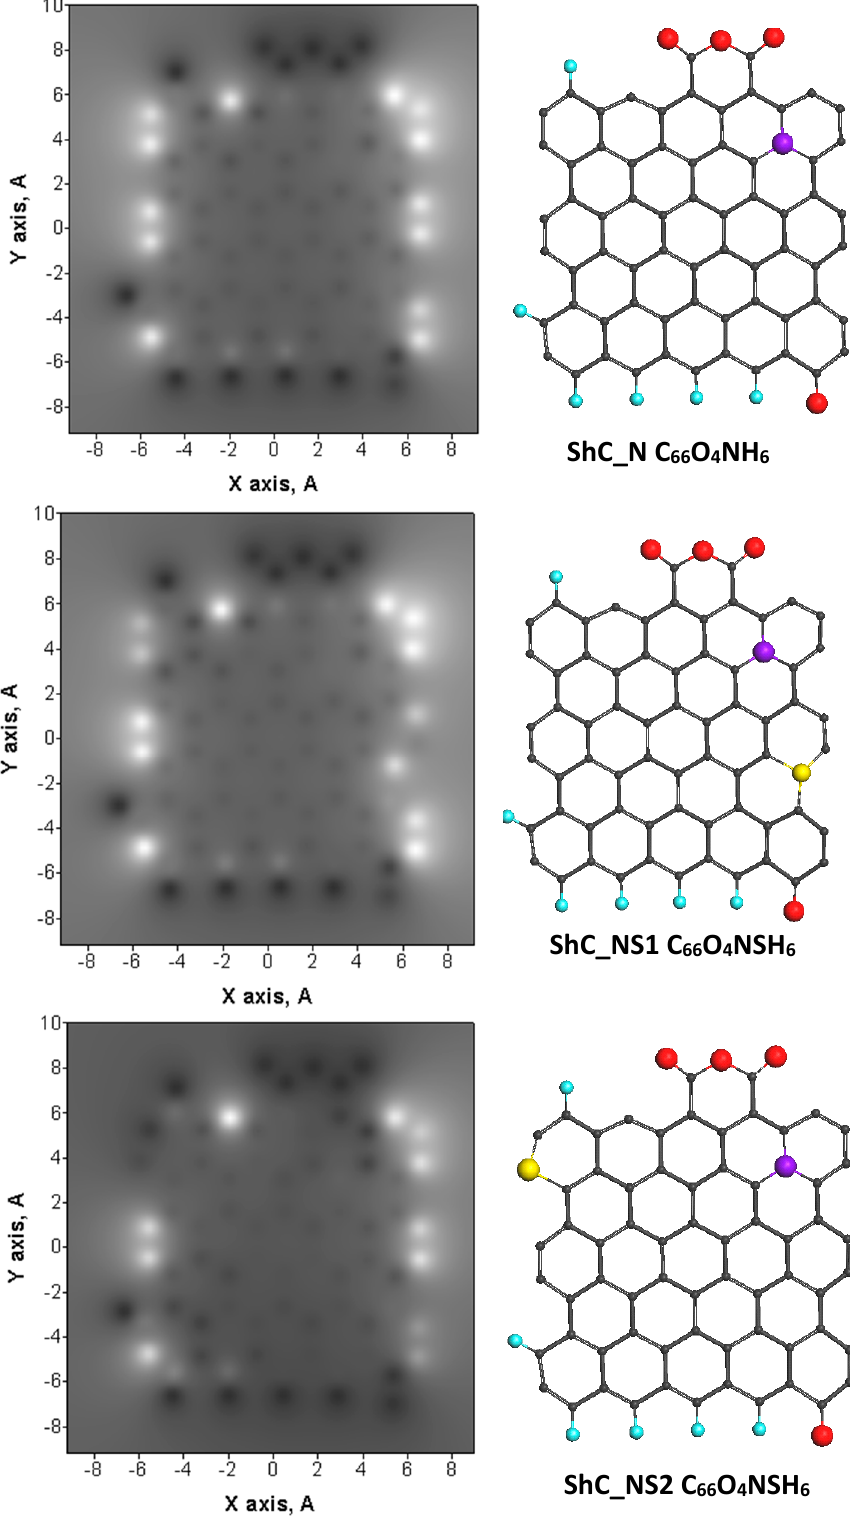
Figure 4. ACS N DA maps ( left ) and equilibrium atomic structures ( right ) of shungite carbon graphene oxynitrothiohydride (GONSH) models decorated with single atoms of nitrogen (lilac balls) and sulfur Figure 4. Figure 4. (yellow